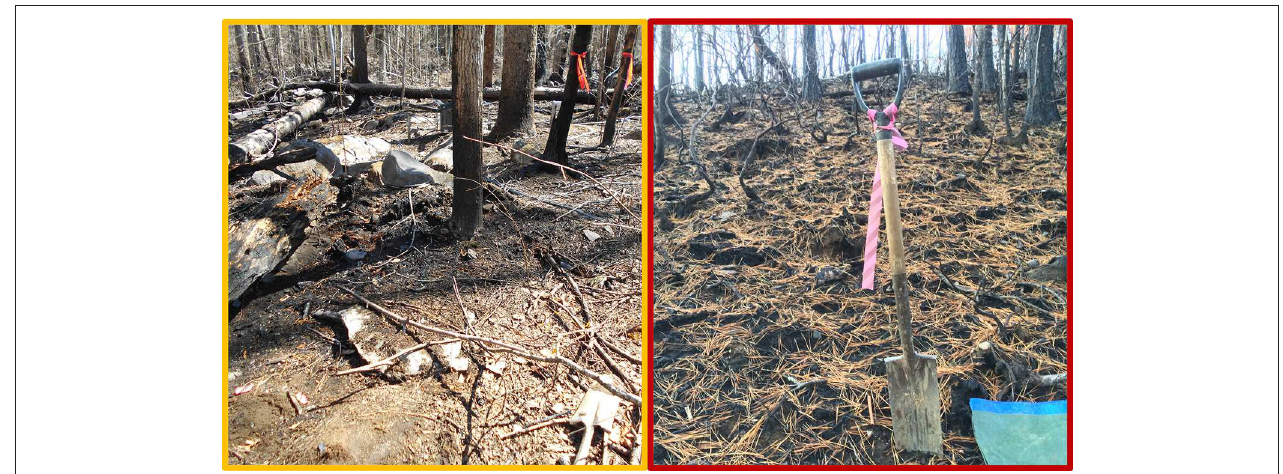
FIGURE 2 | (Left) Example of low severity fire from the soil array (SP-01). Note the burned and unburned areas. (Right) Example of high severity fire from distributed plots (HI-01). This plot had > 80% tree mortality and near complete combustion of O-horizon. Needle fall from fire-killed conifers covers the soil